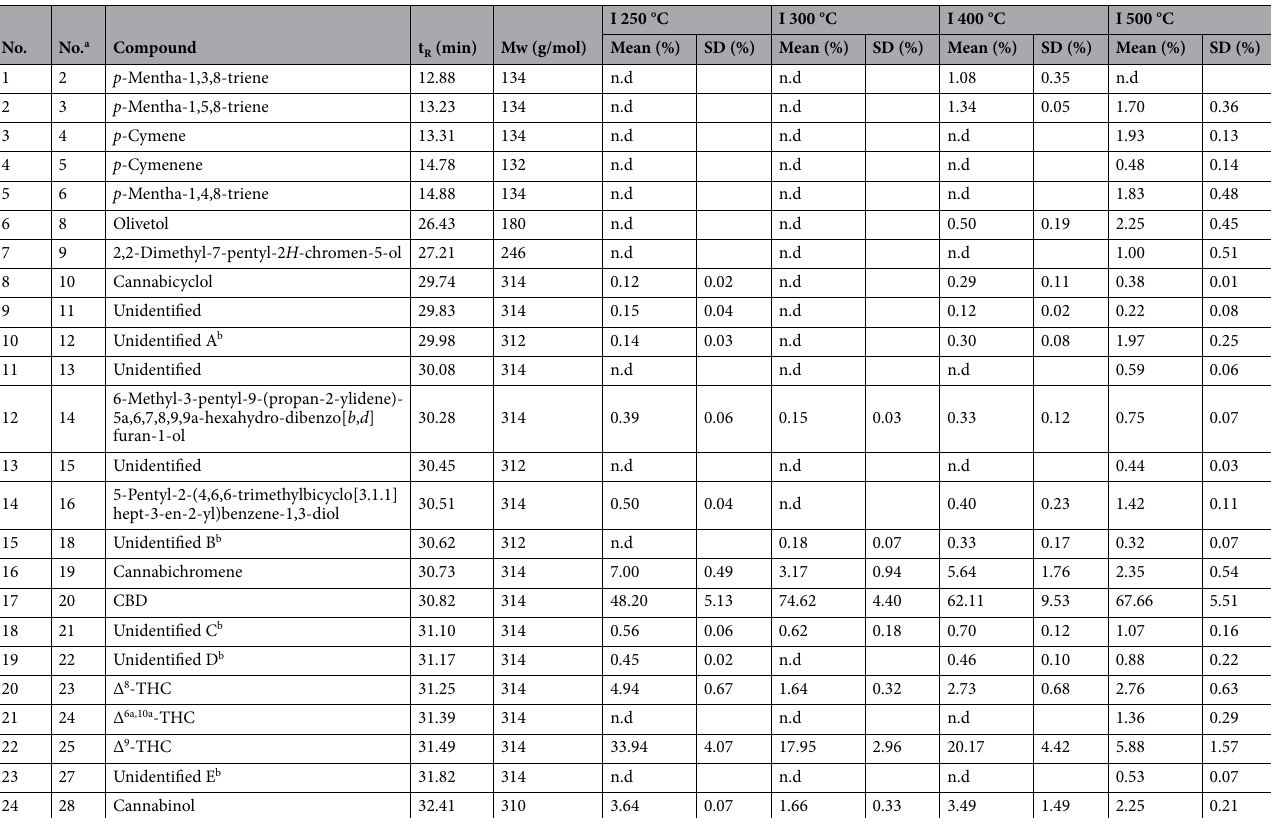
Table 1. Product distribution of CBD at various temperatures in inert atmosphere. Percentages are calculated using peak areas of the total ion current chromatograms. n.d. below detection limit, t R retention time, M W molecular weight. a Compound ID number. b Unidentified compounds which appear in both inert and oxidative